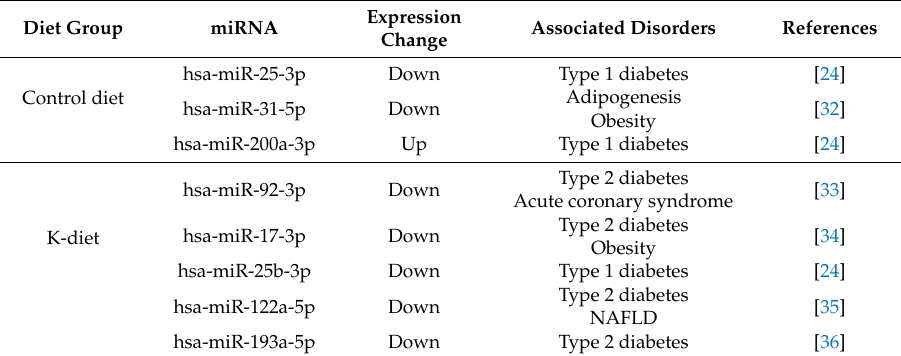
Table 6. Saliva miRs changed in the screening